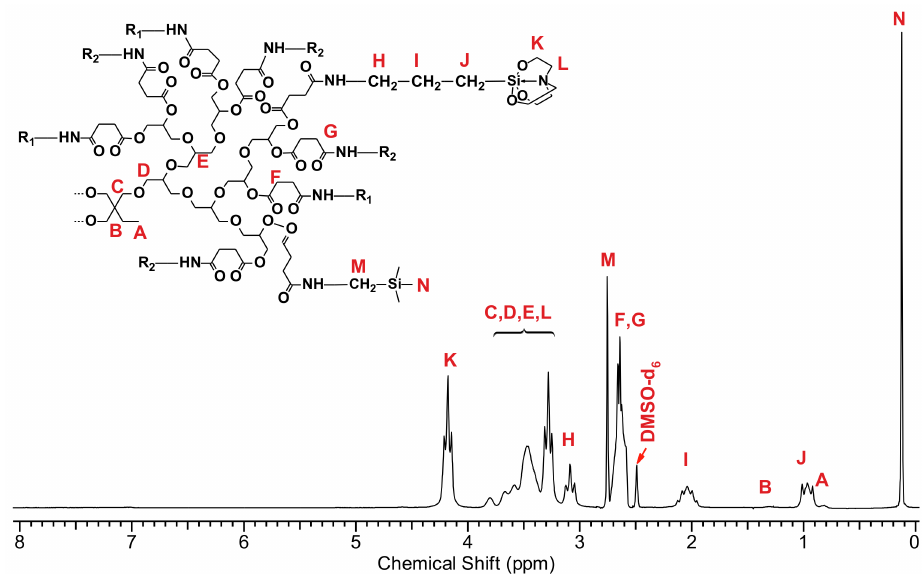
Figure 6. 1H-NMR spectrum and schematic architecture of silatrane-containing polyglycerol. Substitution of free carboxyl groups was monitored by 1 H-NMR, and for both polyg- lycerol and Boltorn H40, the integral intensities of the signals were compared, correspond- ing to methylene groups of silatrane, methylene groups of succinic acid and methyl and methylene groups of